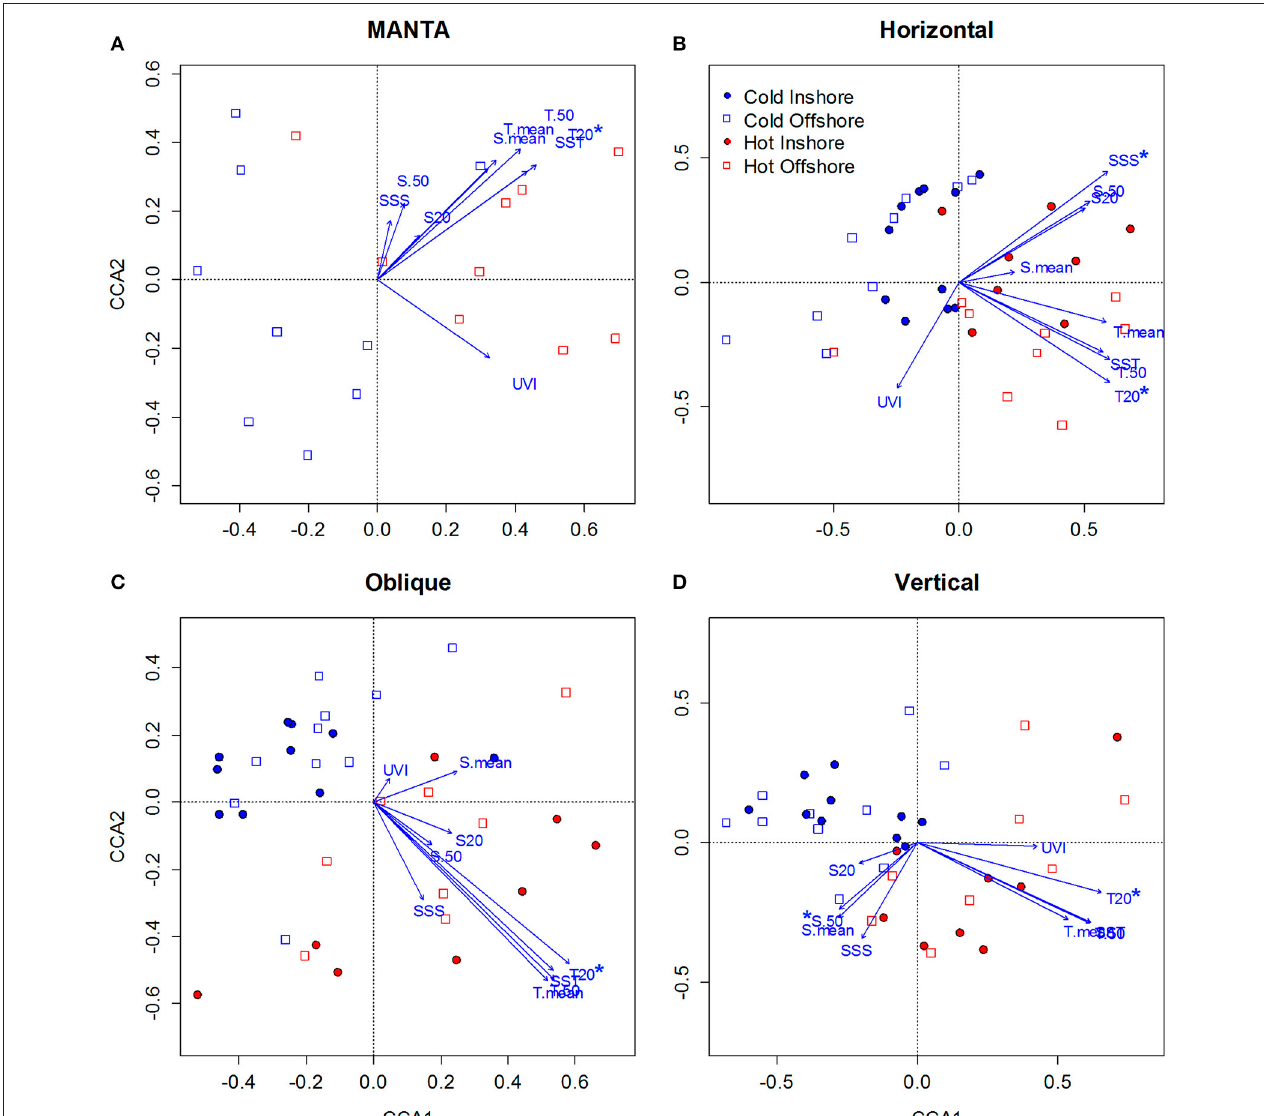
FIGURE 7 | Canonical Correspondence Analysis (CCA) ordination diagrams of samples in relation to environmental variables [Sea Surface Temperature (SST), Mean Temperature of the water column (T.mean), Mean Temperature of the water column from 0 to 50m (T.50), Mean Temperature at 20m (T.20), Sea Surface Salinity (SSS), Mean Salinity of the water column (S. mean), Mean Salinity of the water column from 0 to 50m (S.50), Mean Temperature at 20m (S.20), and UV index (UVI] for zooplankton taxonomic composition data sampled over the central Red Sea. (A–D) correspond to the MANTA, Bongo horizontal, Bongo oblique and vertical hauls respectively. Blue represents the cold season and red the hot season, while empty squares correspond to offshore and full circles to inshore samples. The direction of the arrow indicates the direction of the correlation with respect to the community assemblage composition, while the length of the arrow indicates the strength of that correlation. Environmental variables showing significant correlation (Monte-Carlo permutation test, p < 0.05) with the zooplankton seasonal distribution are indicated with an asterisk.